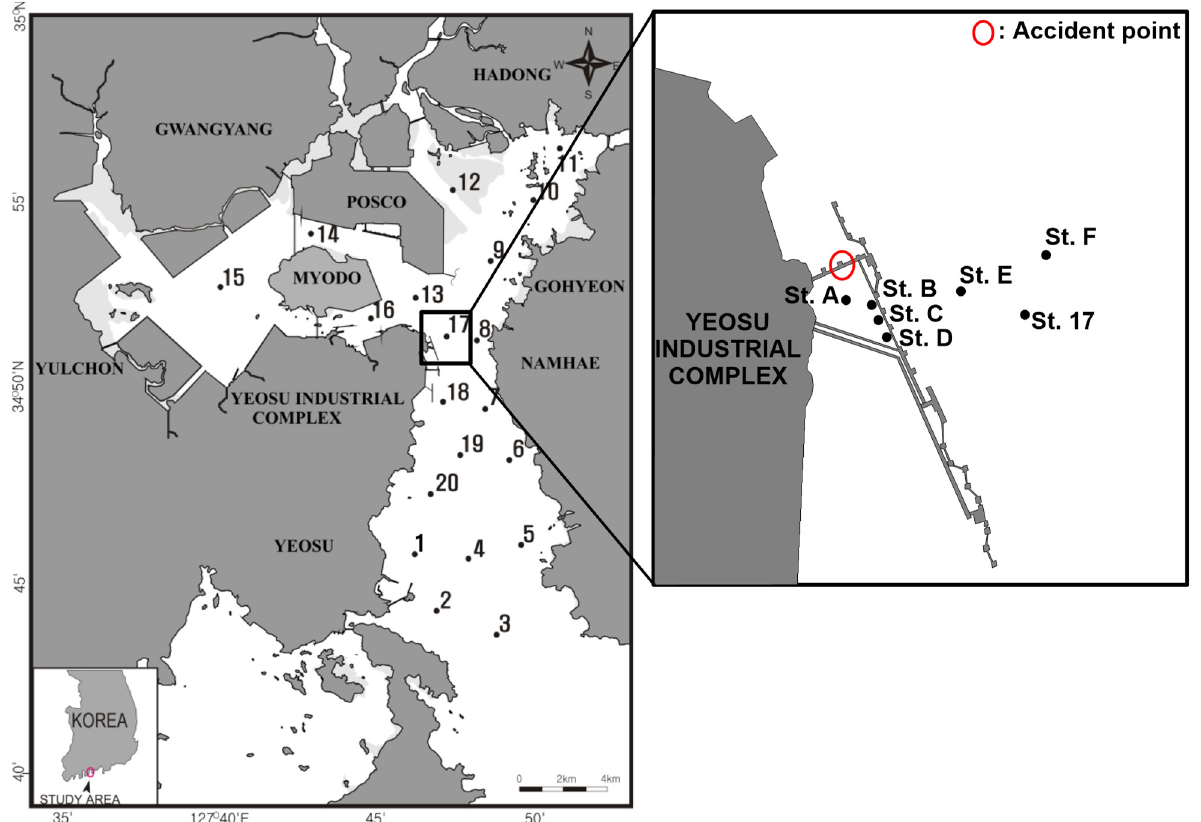
Figure 1. Sampling locations for surface sediment collection in the Wu Yi San oil spill site, the Yeosu Channel and Gwangyang Bay, Korea(No 1~20 : the Yeosu Channel and Gwangyang Bay subtidal zone station / St. A~F : Oil spill accident areas station)